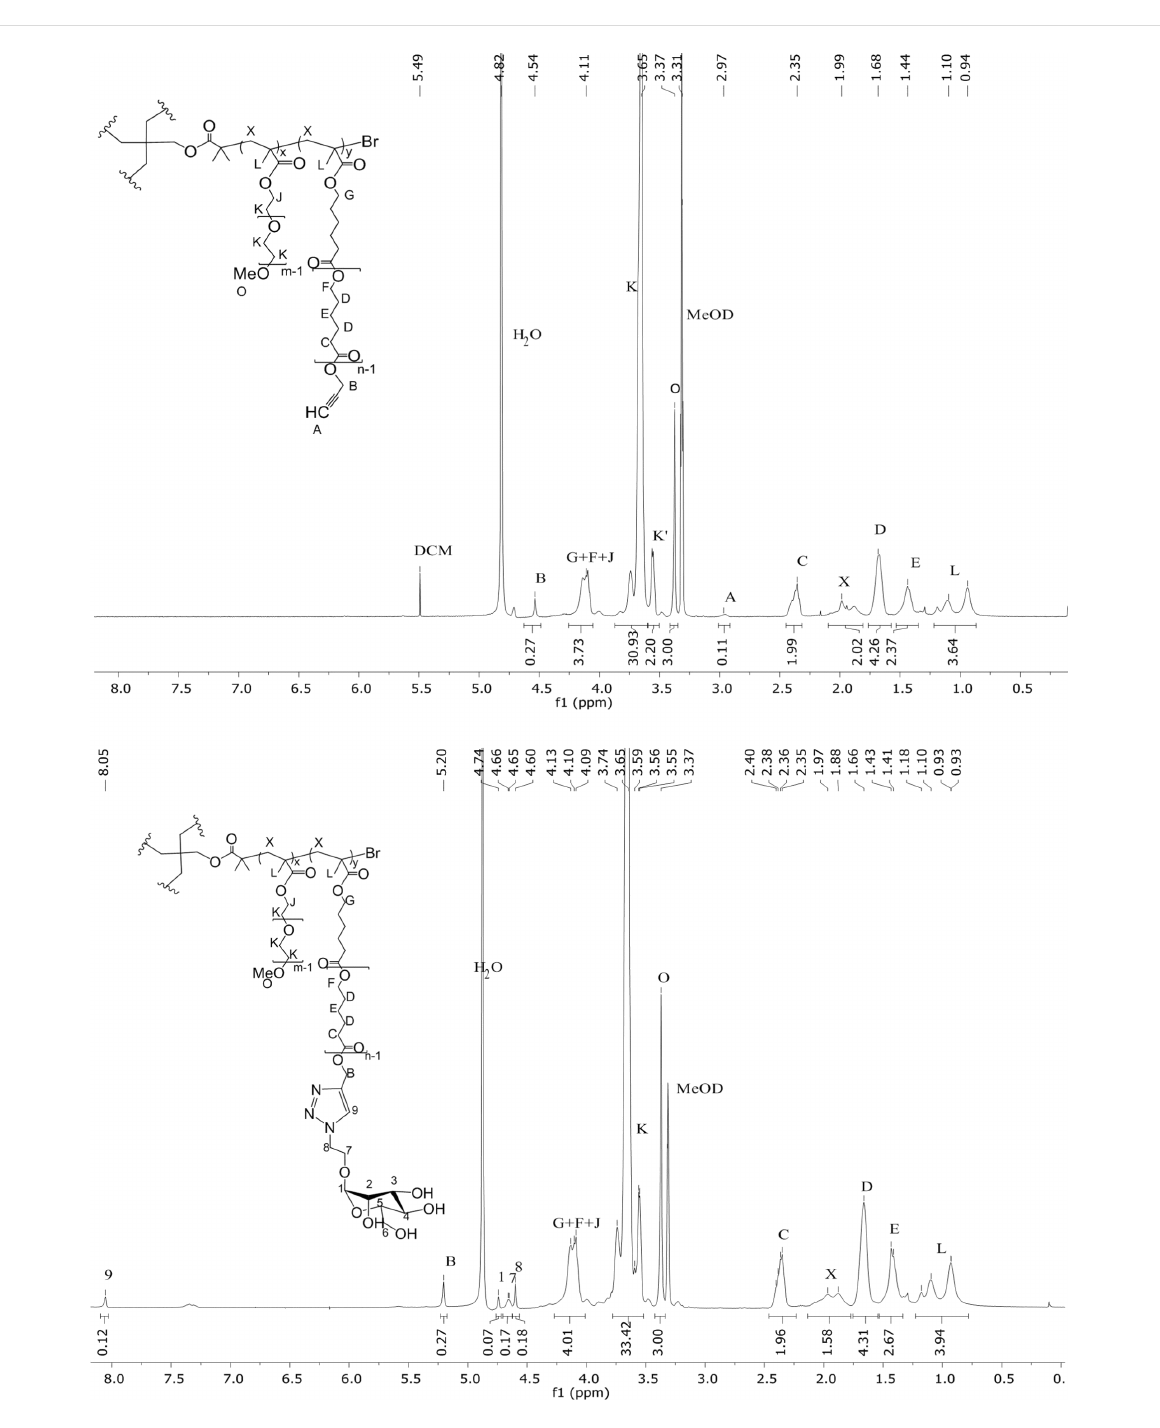
Figure 3: Comparison of the 1 H NMR spectrum of one selected polymer ( A4-PEG 8 -PCL 2 , MeOD) before (upper panel) and after (lower panel) the mannosylation reaction. The disappearance of the peak of the alkyne proton (A, upper) and the appearance of the peak of the triazole (9, lower), together with the presence of the Man-H1 proton (1, lower) in the product demonstrate the formation of the mannosylated polymer ( A4-PEG 8 -PCL 2 - Man 2